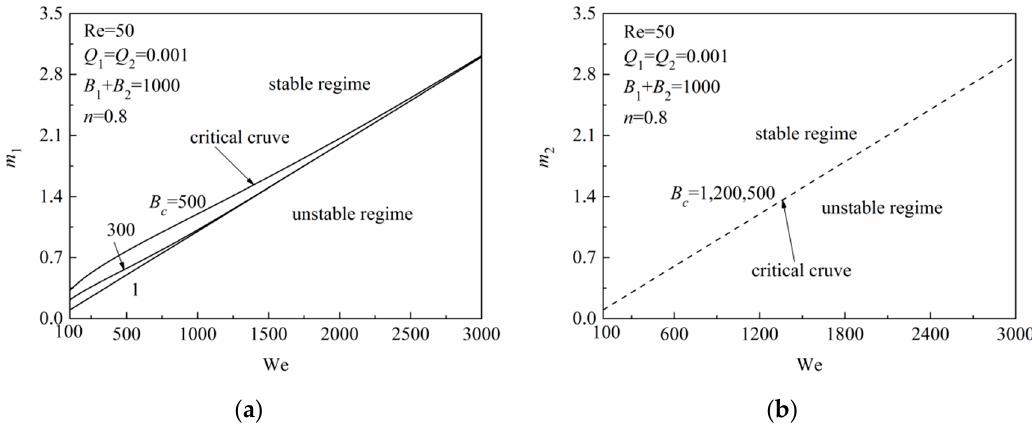
Figure 8. Effect of the boundary asymmetry on the unstable range of power-law plane jets: ( a ) para-sinuous mode (solid line); ( b ) para-varicose mode (dash line).